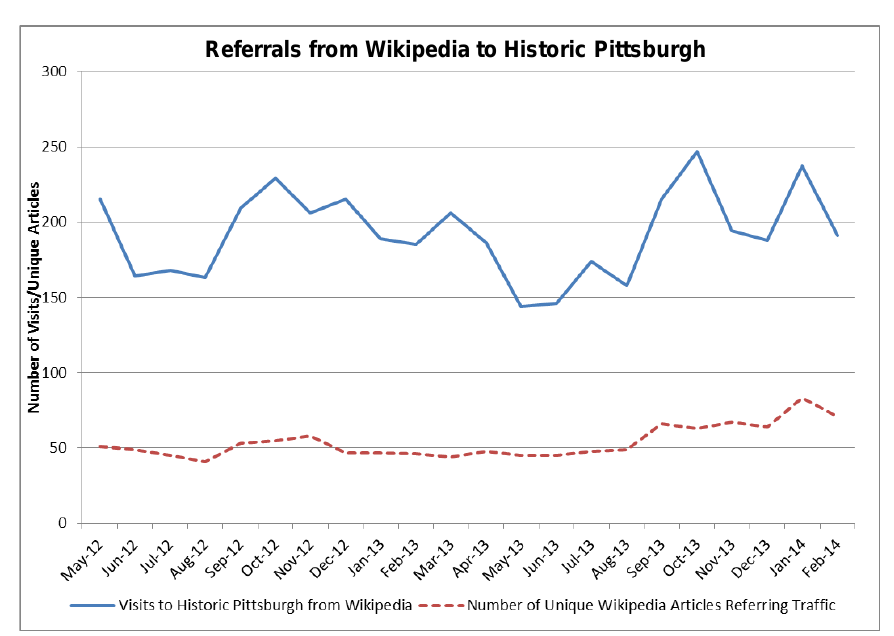
Referrals from Wikipedia to Historic Pittsburgh, May 2012 through February 2014.